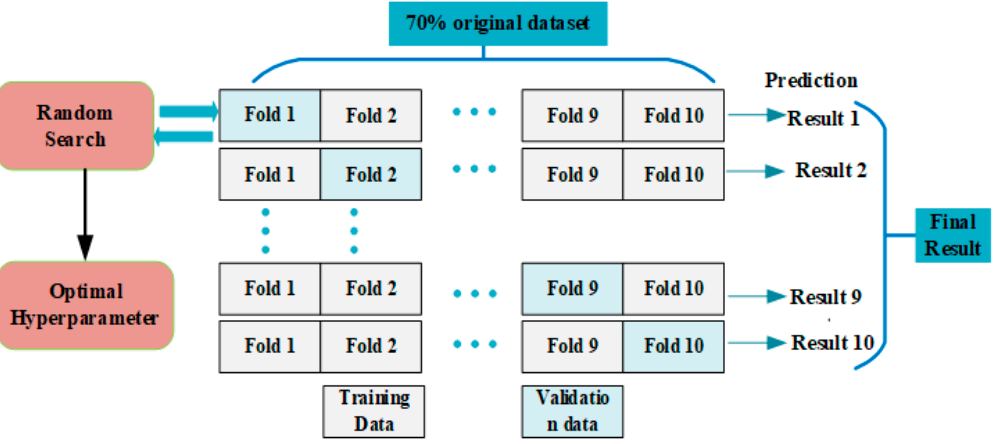
Figure 7 . Hyperparameter